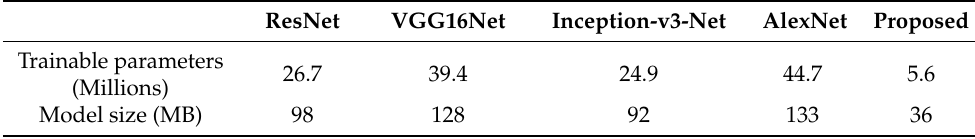
Table 4. Complexity comparison of proposed model and existing models.